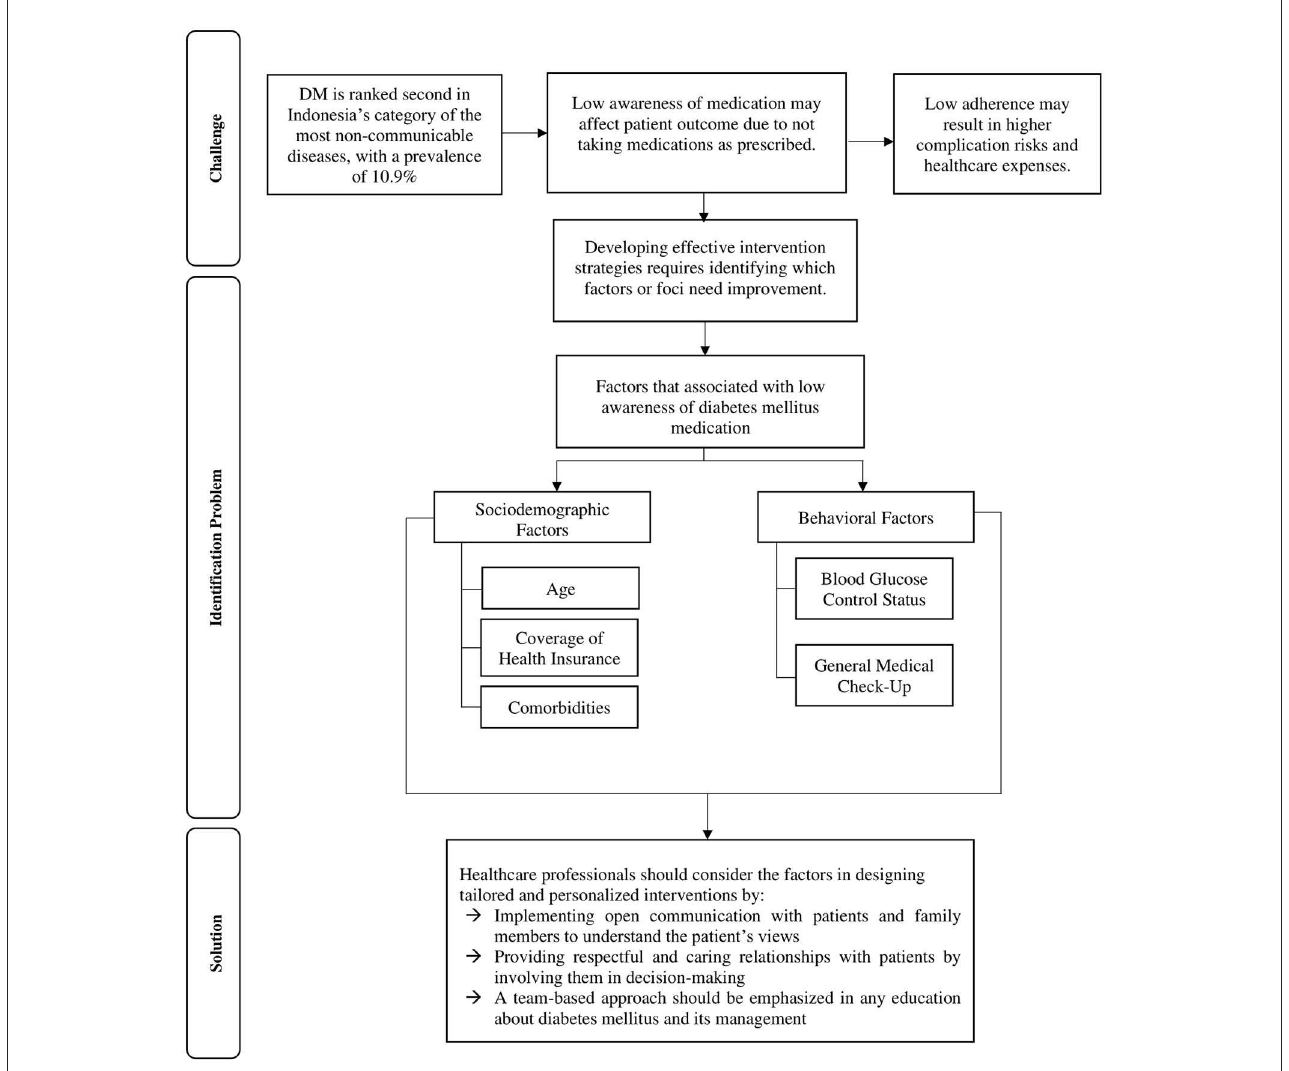
FIGURE1 Problems, challenges and solutions to increase the level of awareness of diabetes mellitus medication in